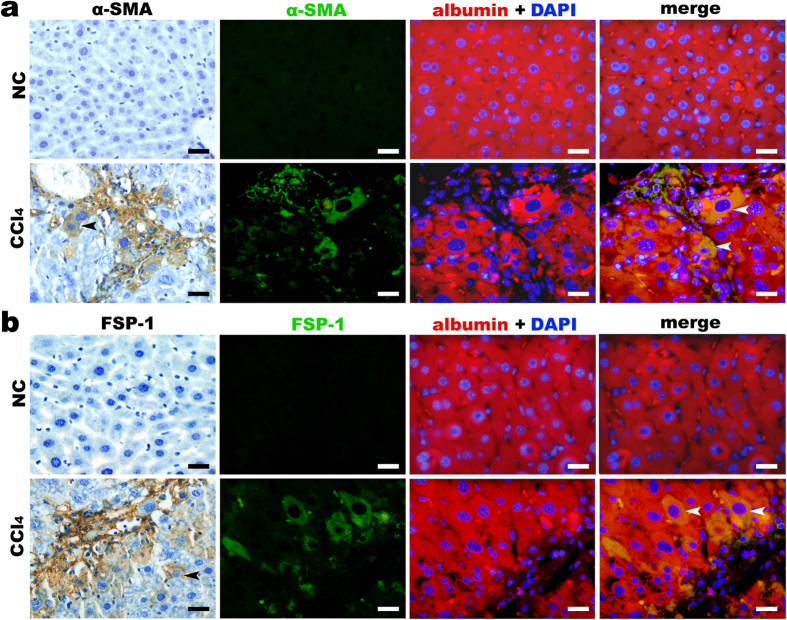
Epithelial-to-mesenchymal transition (EMT) of hepatocytes may contribute to myofibroblasts (MFBs) during hepatic fibrosis.Immunostaining with anti-α-SMA Ab (a) and anti-FSP-1 Ab (b) indicated that a few hepatocytes around the fibrous septa in the fibrotic liver tissues present phenotypes of (myo) fibroblasts. Figures in the first column show immunohistochemical staining with anti-α-SMA Ab and anti-FSP-1; the figures in the second to the fourth column represent double-labelling immunofluorescence using anti-albumin Ab (red) combined with anti-α-SMA Ab (green) or anti-FSP-1 Ab (green). Scale bars = 20 μm. α-SMA, α-smooth muscle actin; Ab, antibody.